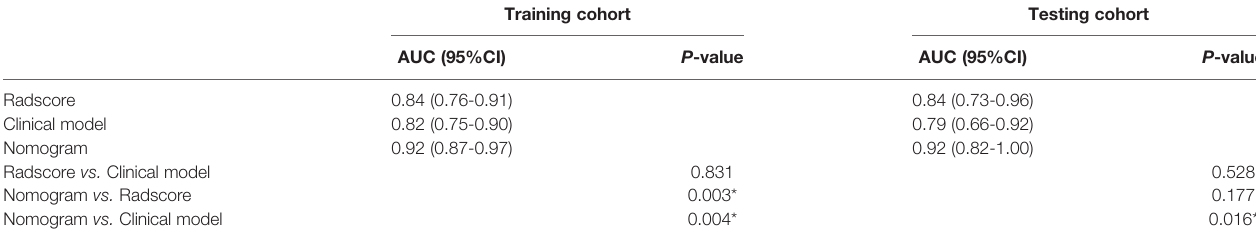
TABLE 2 | AUCs of the Radscore, Clinical model and Nomogram model.